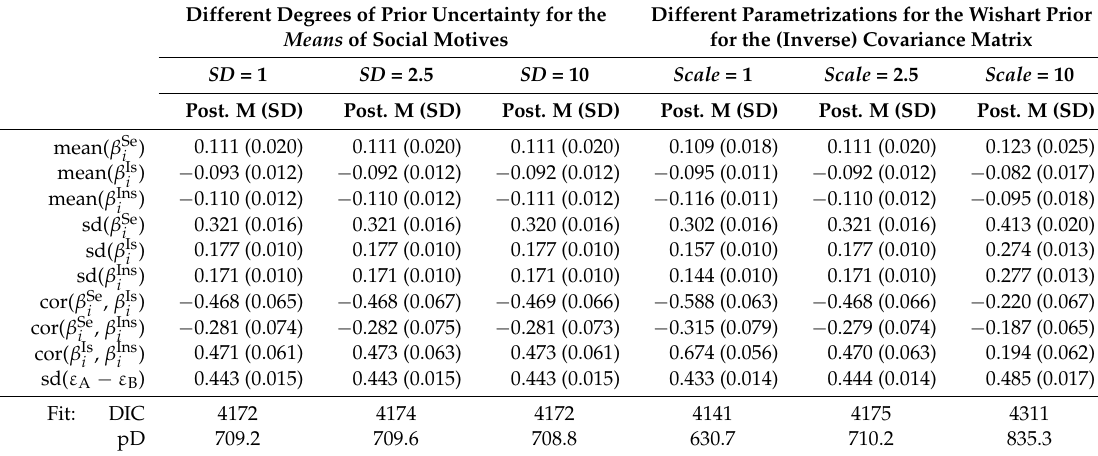
Table A1. Different standard deviations for the priors on µ